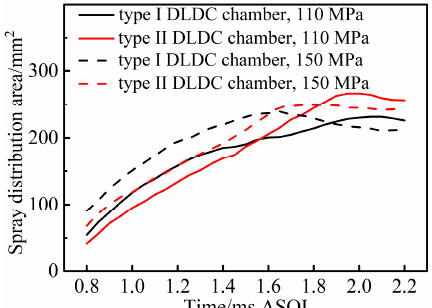
Figure 11. The comparison of fuel spray distribution areas between the two DLDC chambers with medium load, Φ 0.16 mm nozzle, different injection pressures and 5 °CA BTDC injection timing of Mode A.